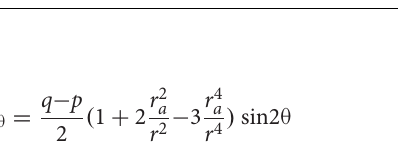
FIGURE 5 | Fracture mode, force chain distribution, and displacement vector of SCS-30 with different cycle